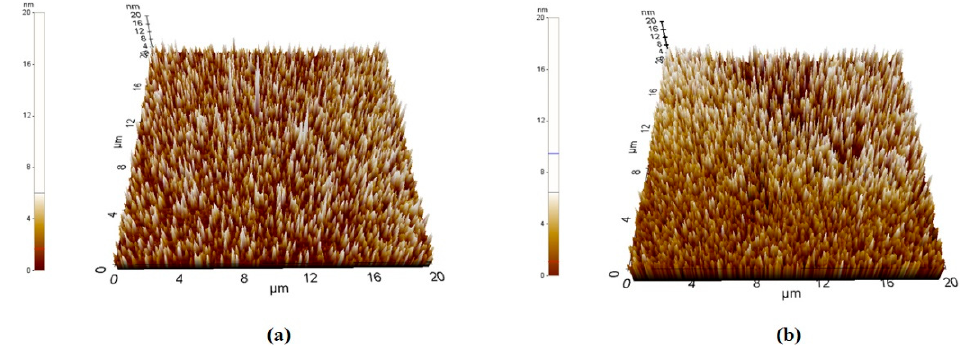
Figure 11. Surface morphology of ITO film obtained via ( a ) open-type FTS and ( b ) closed-type FTS. Table 2. Surface roughness values of prepared ITO films.